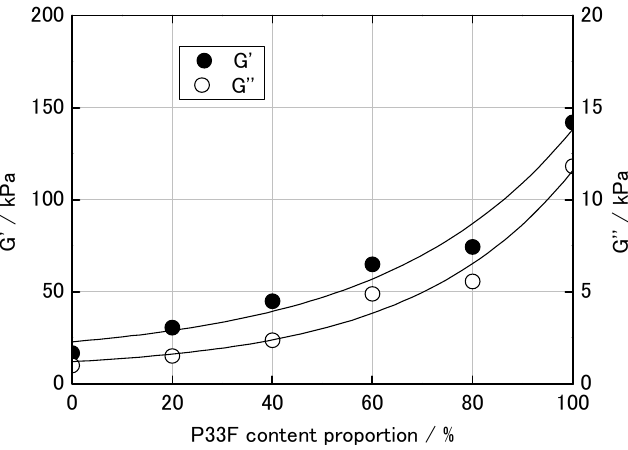
Figure 5 Dynamic viscoelasticity of P33F/P33M obtained by blending two kinds of PVA with different SV